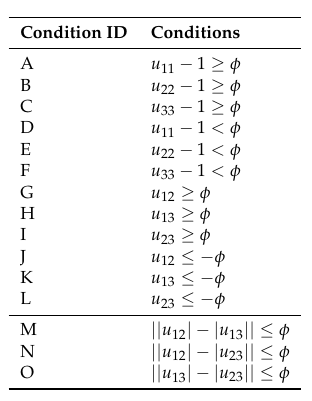
Table 1. The 15 conditions for identifying variants.